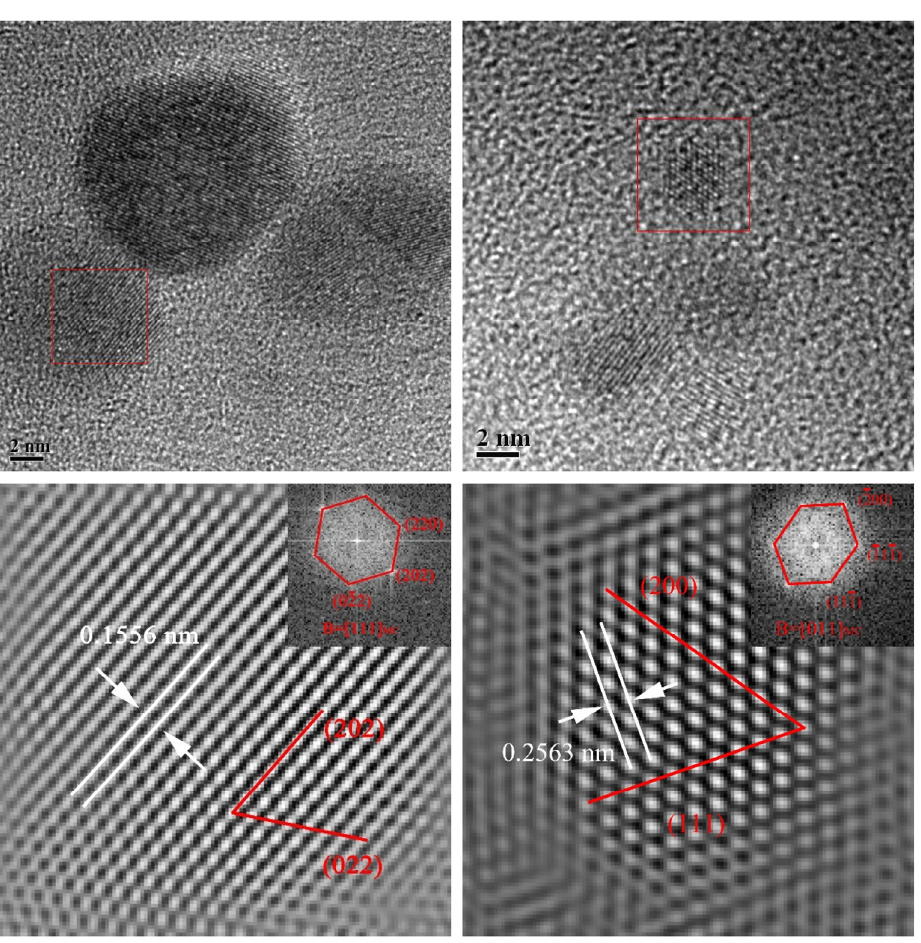
Figure 14. High resolution TEM images of nanometer precipitation at peak temperature of 950 ◦ C under the heat input of 10 kJ/cm.